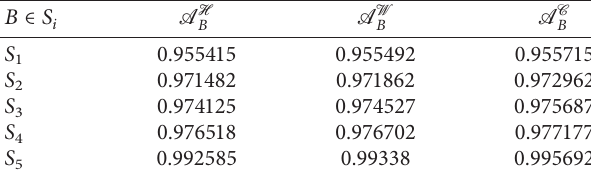
I ∈ S ,i � 1 , 2 , ... , 5 . i ,i � 1 , 2 , .. . , 5. i